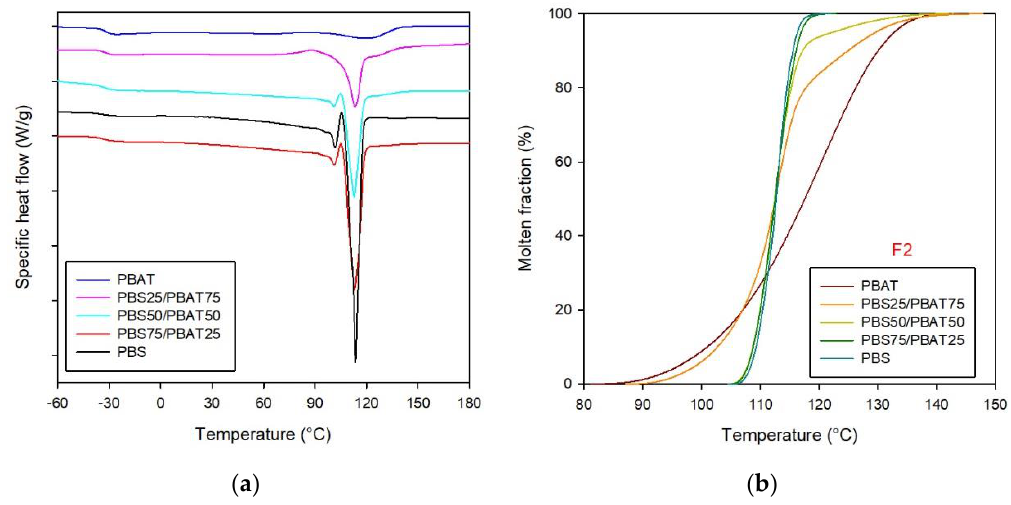
Table 2. DSC results for PBS, PBAT and their blend during the second heating. The values of melting enthalpy in parentheses are normalized with respect to the weight fraction of the polymer in the blends.